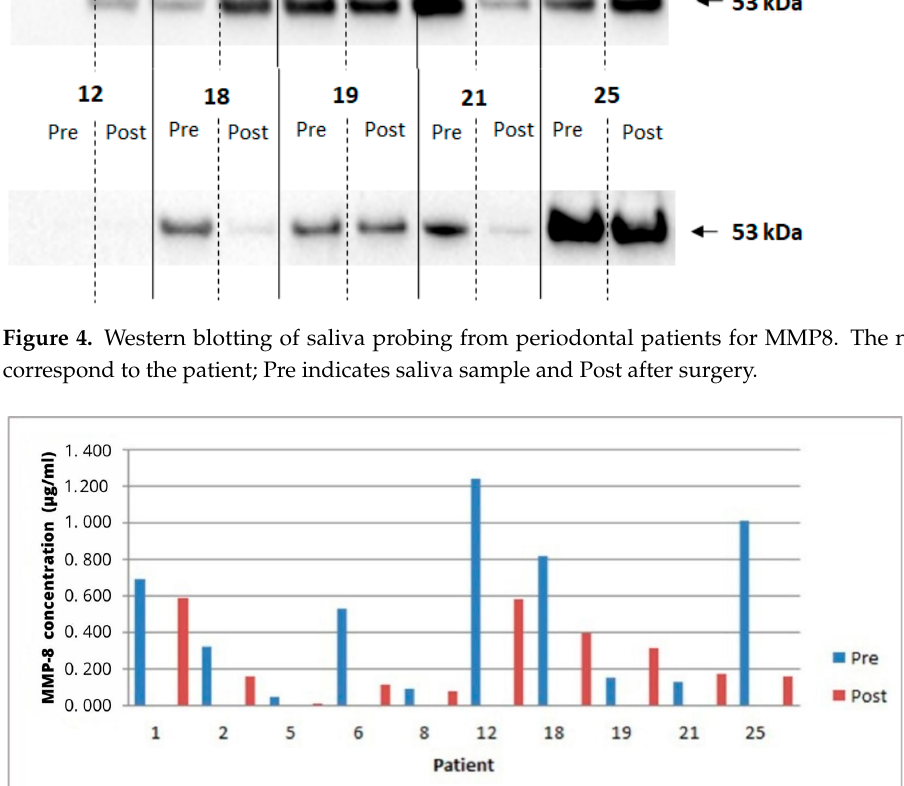
Figure 5. ELISA analysis of the patient’s salivary MMP8 concentration before and after surgery .